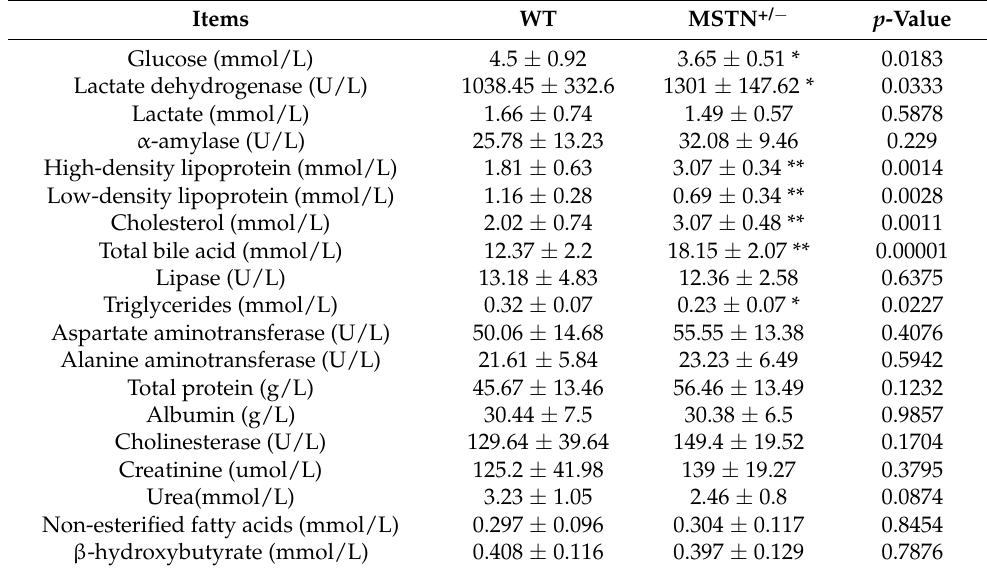
Table 1. Serum physiological and biochemical parameters of MSTN +/ − and WT cattle.